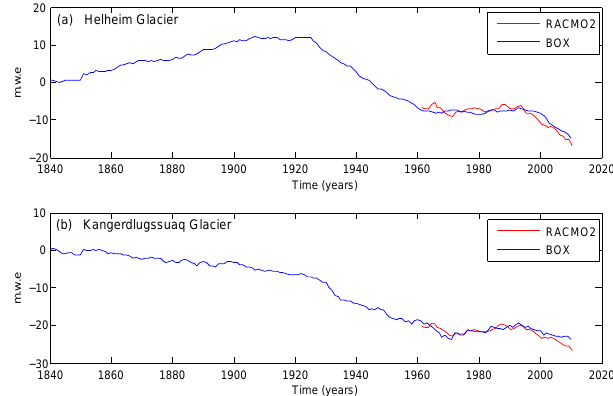
Figure 3. (a) Time series of cumulative melt-induced elevation changes in metre water equivalent (mw.e.) at the location marked by a white star in Fig. 4a; (b) same as (a) but for the location marked by a white star in Fig. 5a.